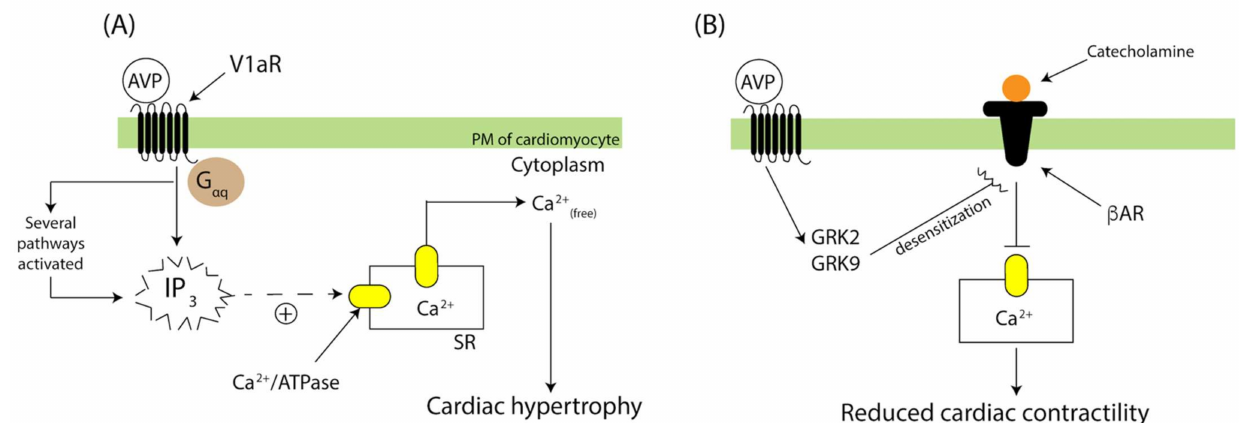
Figure 4. AVP-V1aR signaling contributes to weaker myocardial contractions and cardiac remodeling in heart failure (HF). ( A ) AVP binding to V1aR during HF activates G α q protein-mediated signaling, which amplifies IP 3 signaling and triggers Ca 2+ release (dashed) from the sarcoplasmic reticulum (SR). Prolonged Ca 2+ mobilization leads to myocardial hypertrophy. ( B ) G α q -independent signaling promotes GRK recruitment to the plasma membrane (PM) decreasing catecholamine- β adrenergic receptor ( β AR) activation and Ca 2+ mobilization. When prolonged, this condition impairs myocardial